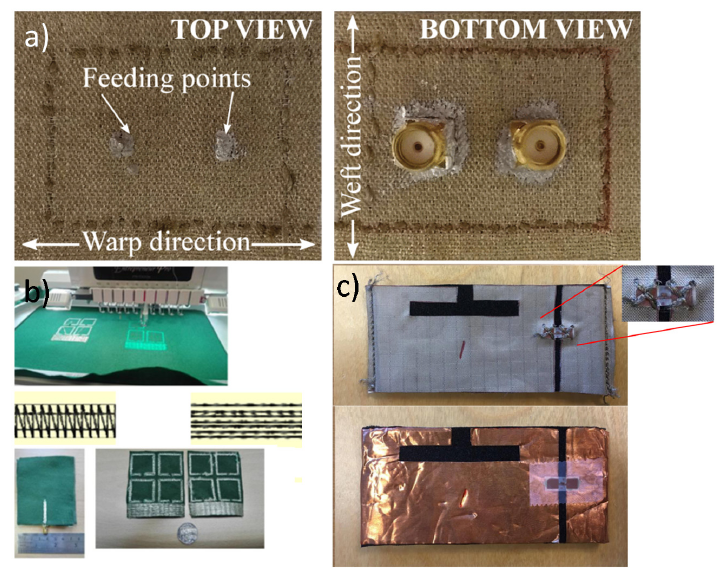
Figure 10. Embroidery and stitching based flexible antennas. ( a ) Novel mixed embroidered-woven textile integrated waveguide (TIW) antenna: top and bottom views [128], ( b ) embroidery metamaterial antenna manufacturing process with stitch pattern embroidery layout and embroidered antennas [129], and ( c ) fabricated e-textile based on a slotted patch antenna created with a sewing machine and copper tape [127].